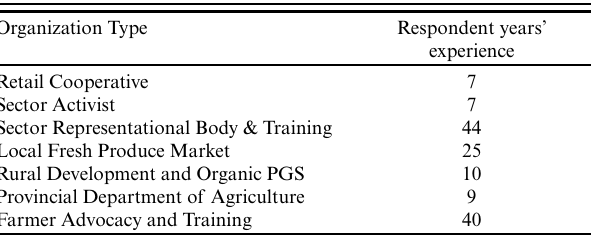
Table 2 . List of sector organization